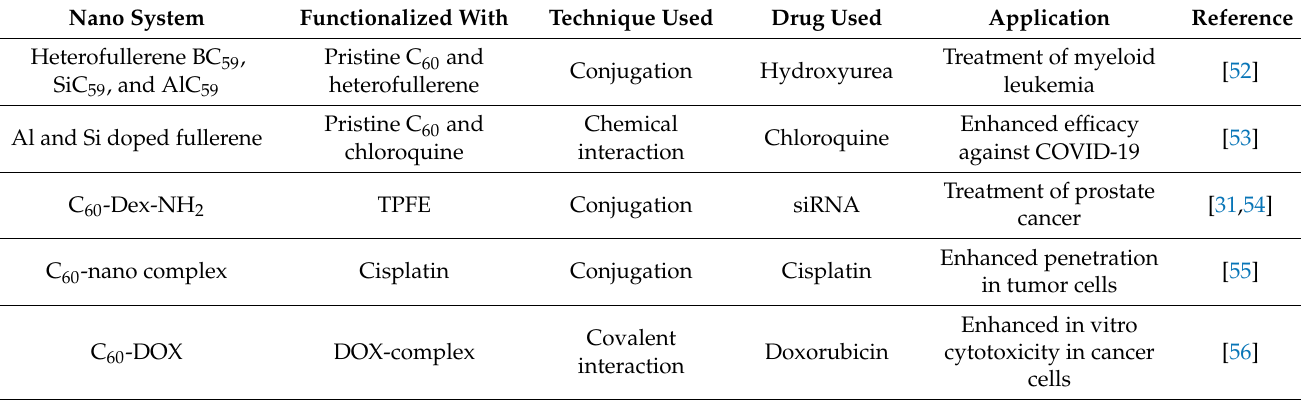
Table 2. Recent developments in fullerene-based drug delivery